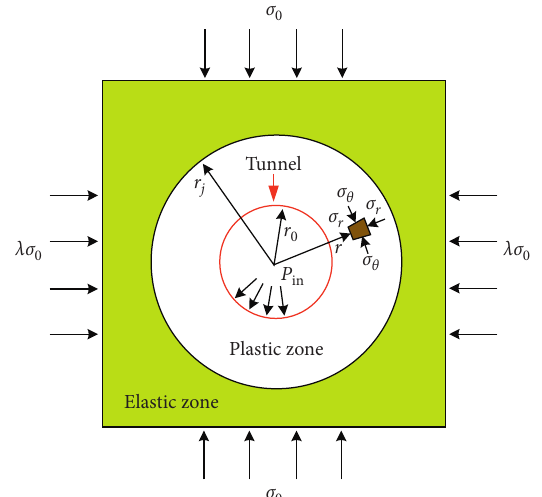
Figure 1: Mechanical model of a deep circular